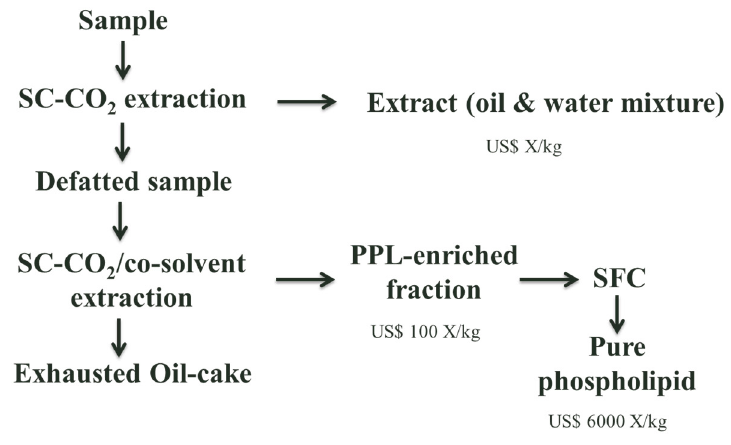
Figure 2. PPL production [51].